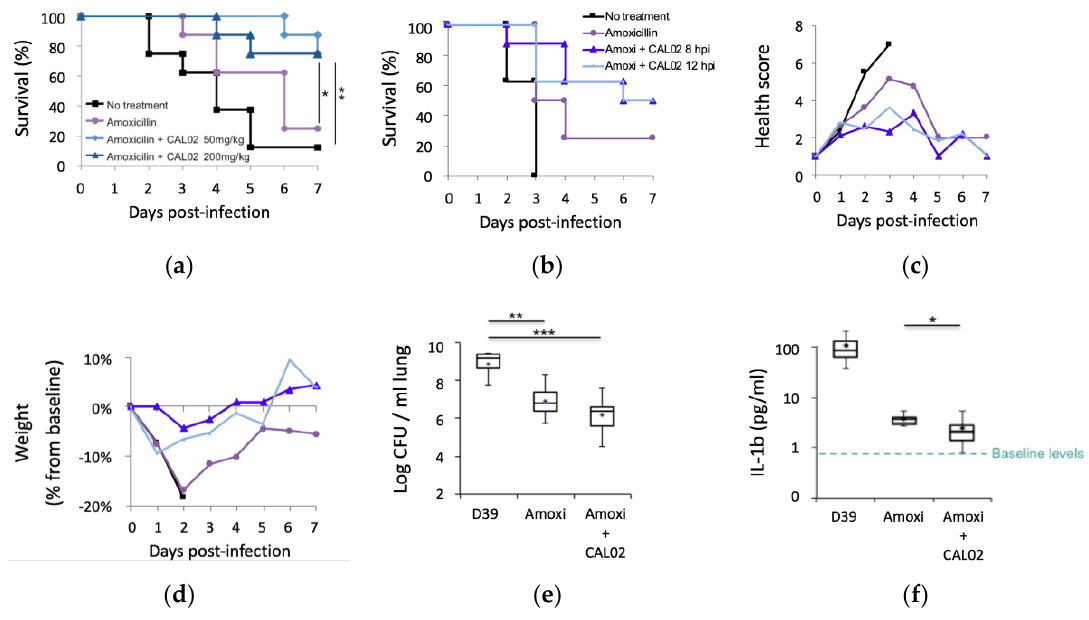
Figure 3. CAL02 in addition to antibiotics in acute pneumonia caused by S. pneumoniae . CD-1 mice were challenged with a lethal intranasal infection of S. pneumoniae D39. A single dose of amoxicillin (0.2 mg/kg in ( a – d ), 1 mg/kg in ( e – f )) was administered subcutaneously at 4 hours post-infection. Study ( a ): A single dose of CAL02 (50 or 200 mg/kg) was administered intravenously at 4 hours post-infection. Study ( b ): A single dose of CAL02 (50 mg/kg) was administered intravenously at 8 or 12 hours post-infection. At the end of the study, all surviving mice treated with CAL02 had fully recovered as indicated by health scores( c ) and weight ( d ). ( e – f ) Impact of CAL02 (200 mg/kg) administered 6 hours after antibiotics on bacterial loads in lungs ( e ) and on blood IL-1beta ( f ), measured at 30 hours post-infection; ( a – e ) n = 8 per group; ( f ) n = 4 in the untreated group; and n = 8 in treated groups. * p < 0.05, ** p < 0.01, *** p < 0.005; Log-rank (Mantel – Cox) test p < 0.05. [25].